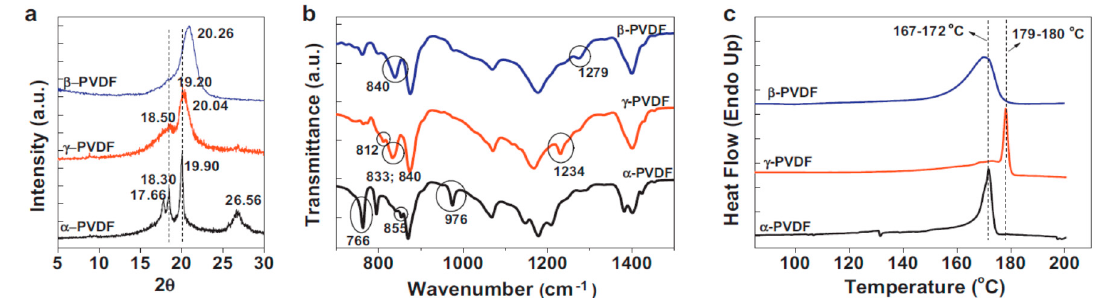
Figure 5. ( a ) XRD patterns, ( b ) FTIR spectra, and ( c ) DSC curves of the polymorphs of PVDF. Reproduced with permission from [2], published by Elsevier, 2014.